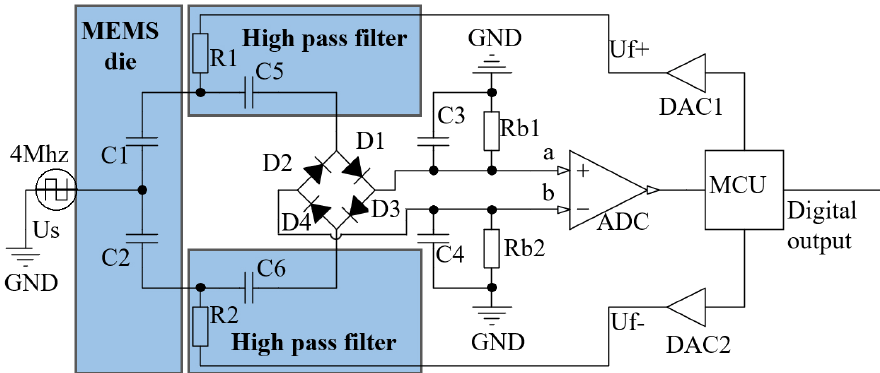
Figure 4. Schematic diagram of the capacitive closed-loop accelerometer based on ring-diode capac- itance detection. Table 1. Closed-loop control circuit element